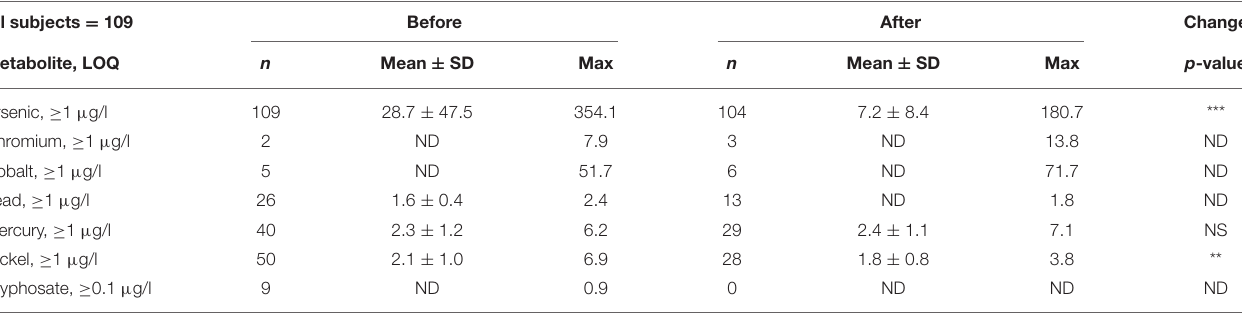
The heavy metals measured are presented in alphabetical order in µ g/l. Glyphosate, as a marker of the main pesticide of the world, is also indicated in µ g/l. The total number of subjects is 109; the number of subjects (n) above the level of quantification is given for each parameter. ND, not determined; NS, not significant. P-values < 0.01 are indicated as ** ; p < 0.001 as ***